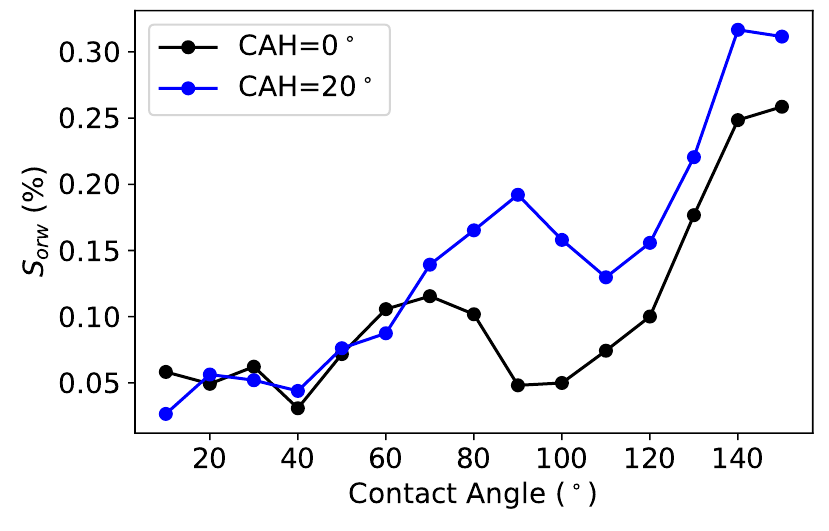
Figure 13. Effect of the wettability on S wi .